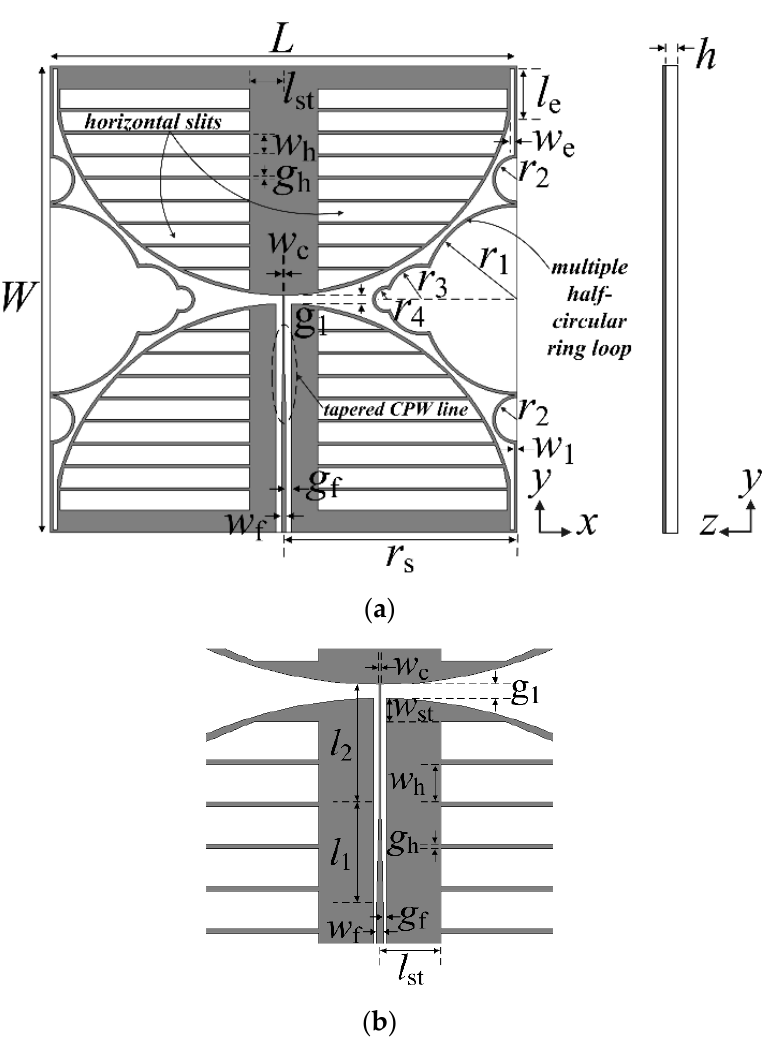
Figure 1. Geometry of the proposed miniaturized wideband loop antenna: ( a ) the whole view; ( b ) the tapered CPW feed line.